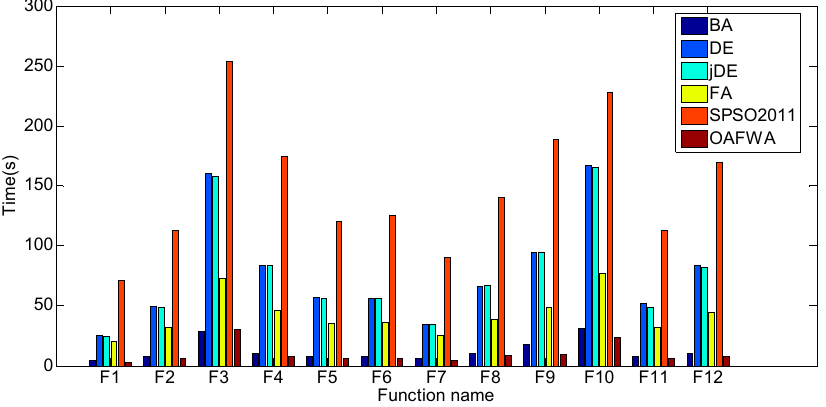
Figure 4. Runtime cost of the six algorithms for twelve functions when popSize = 40.